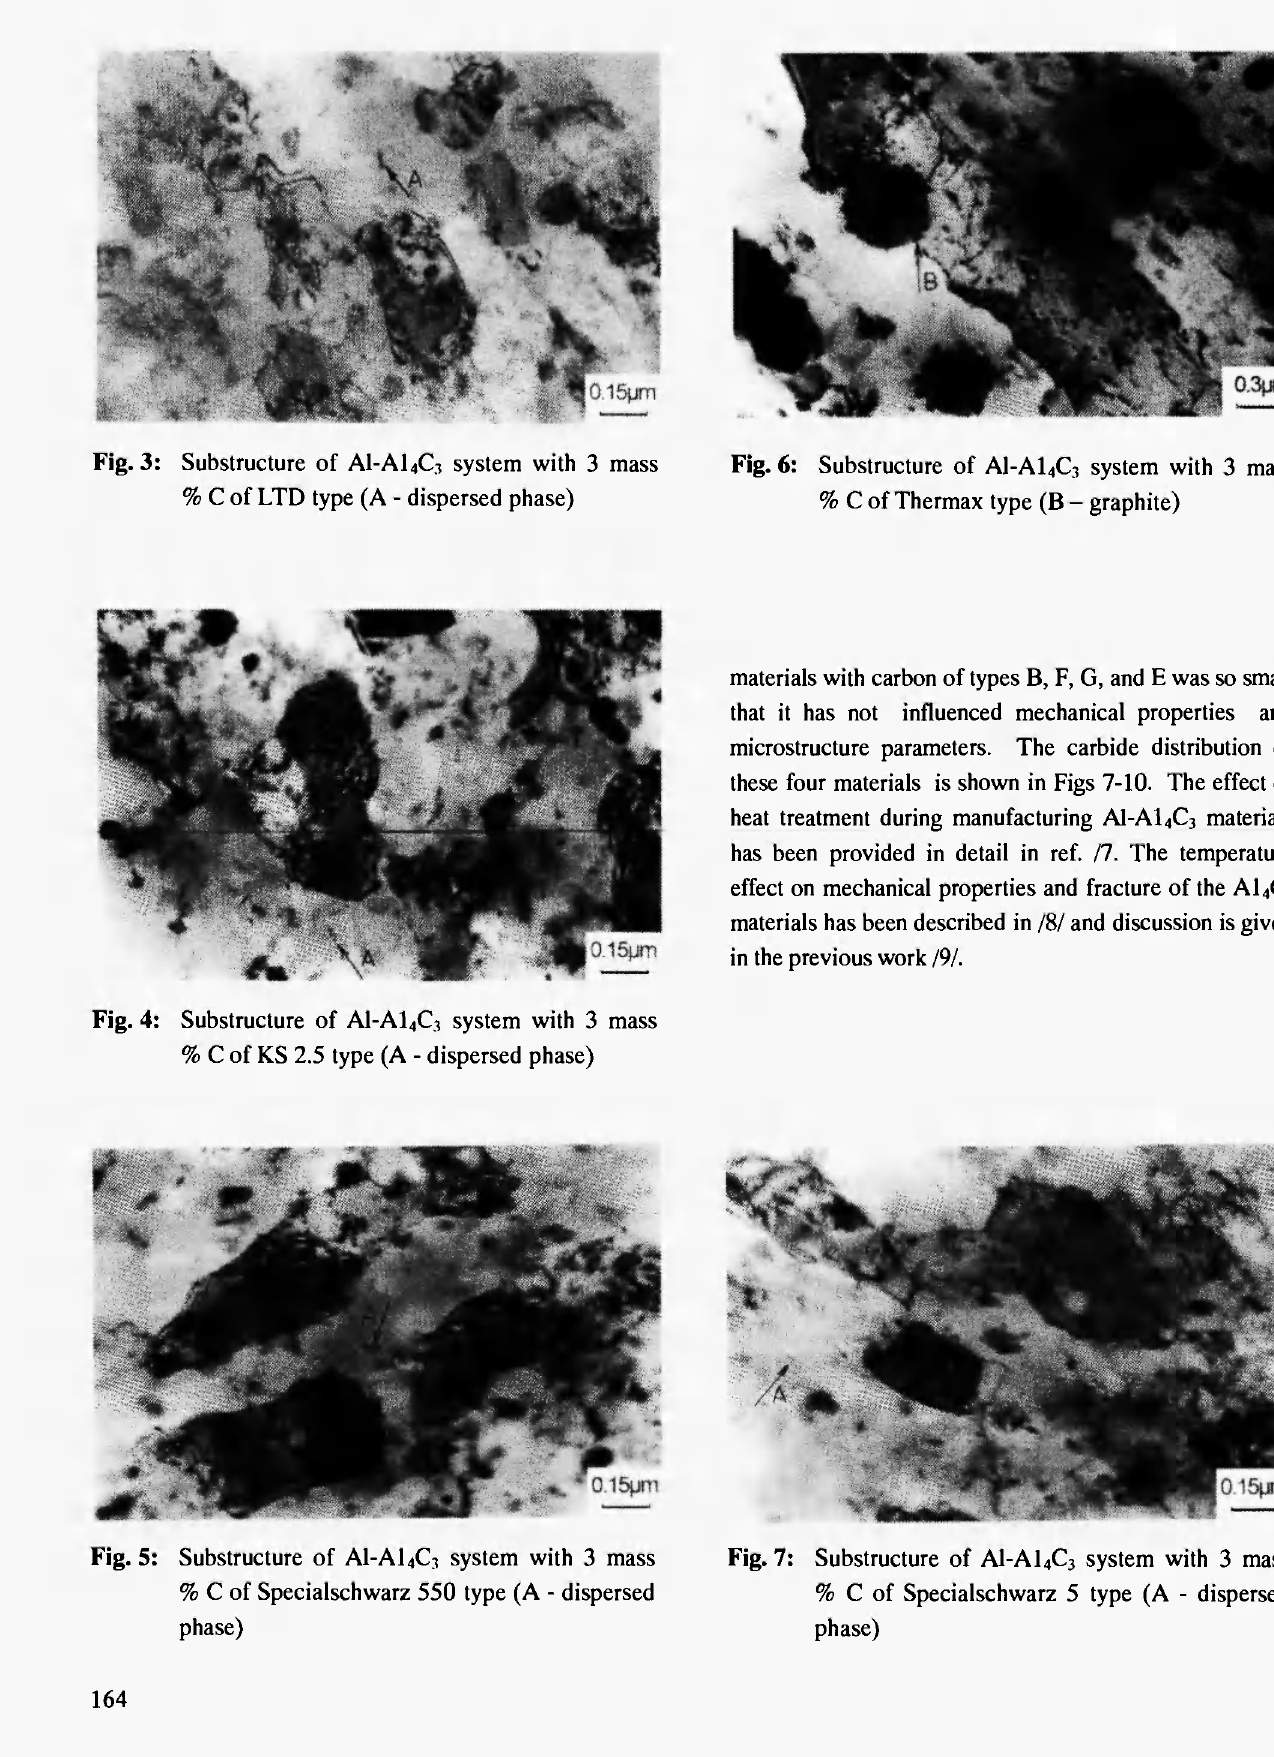
Fig. 5: Substructure of AI-AI4C3 system with 3 mass % C of Specialschwarz 550 type (A - dispersed phase)